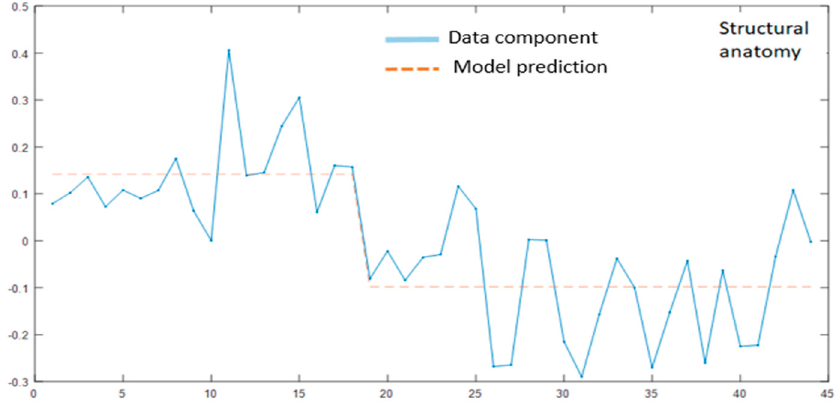
Figure 2. MLM components and subjects score for each of the modality. The first subjects, to the left (x-axis = N of subjects) correspond to the schizophrenia group and the rest to the depression group. The blue lines correspond to the calculated empirical components and the red dashed lines correspond to its projections/prediction in the space defined by the condition of interest, i.e., the differences between the two diagnostic groups. First segment of the figure shows the specific components identified using the resting state fMRI data, second segment shows the eigen-components which best summarize the fMRI task-related data; last segment shows the specific components for the anatomical differences between the two patient groups.